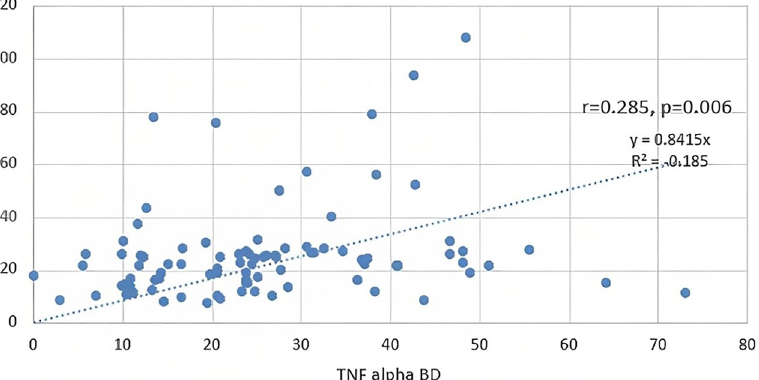
Figure 2: Serum TNF- α levels in dialysis patients, predialysis patients and healthy controls.